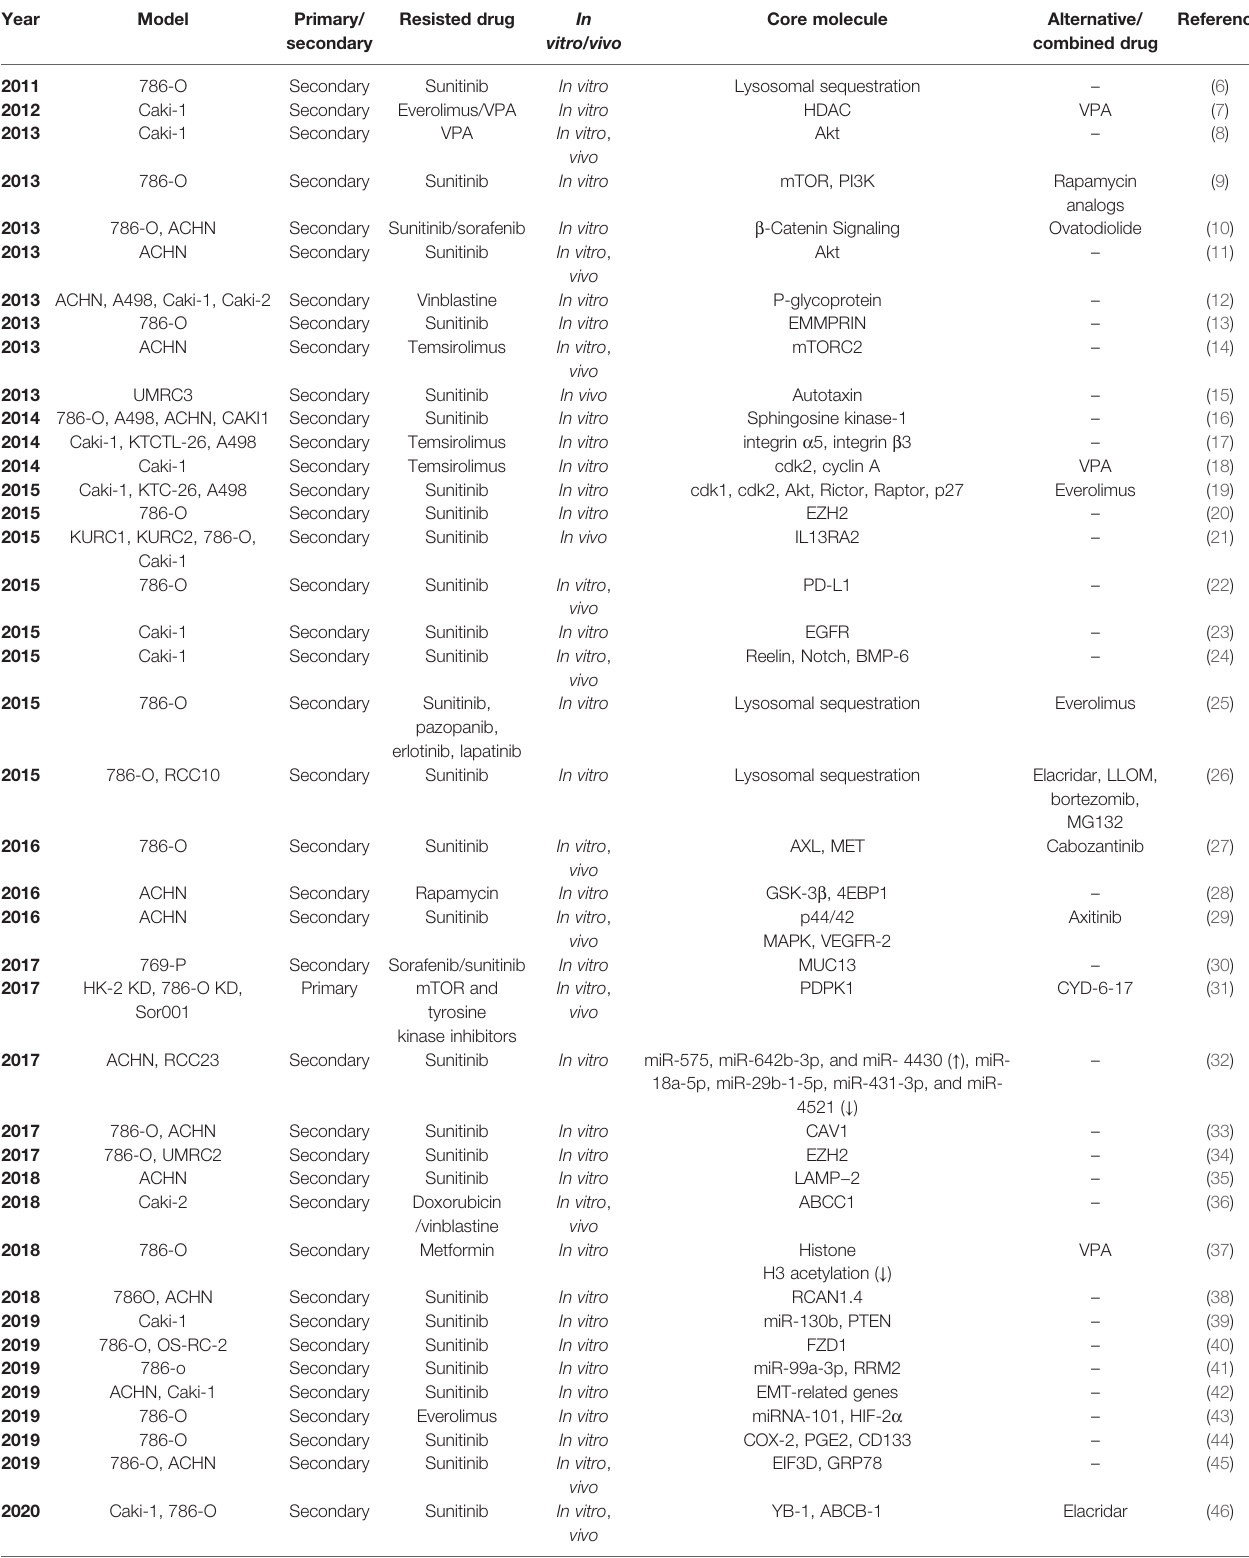
TABLE 1 | Researches on RCC drug resistance using traditional in-vitro and in-vivo models.